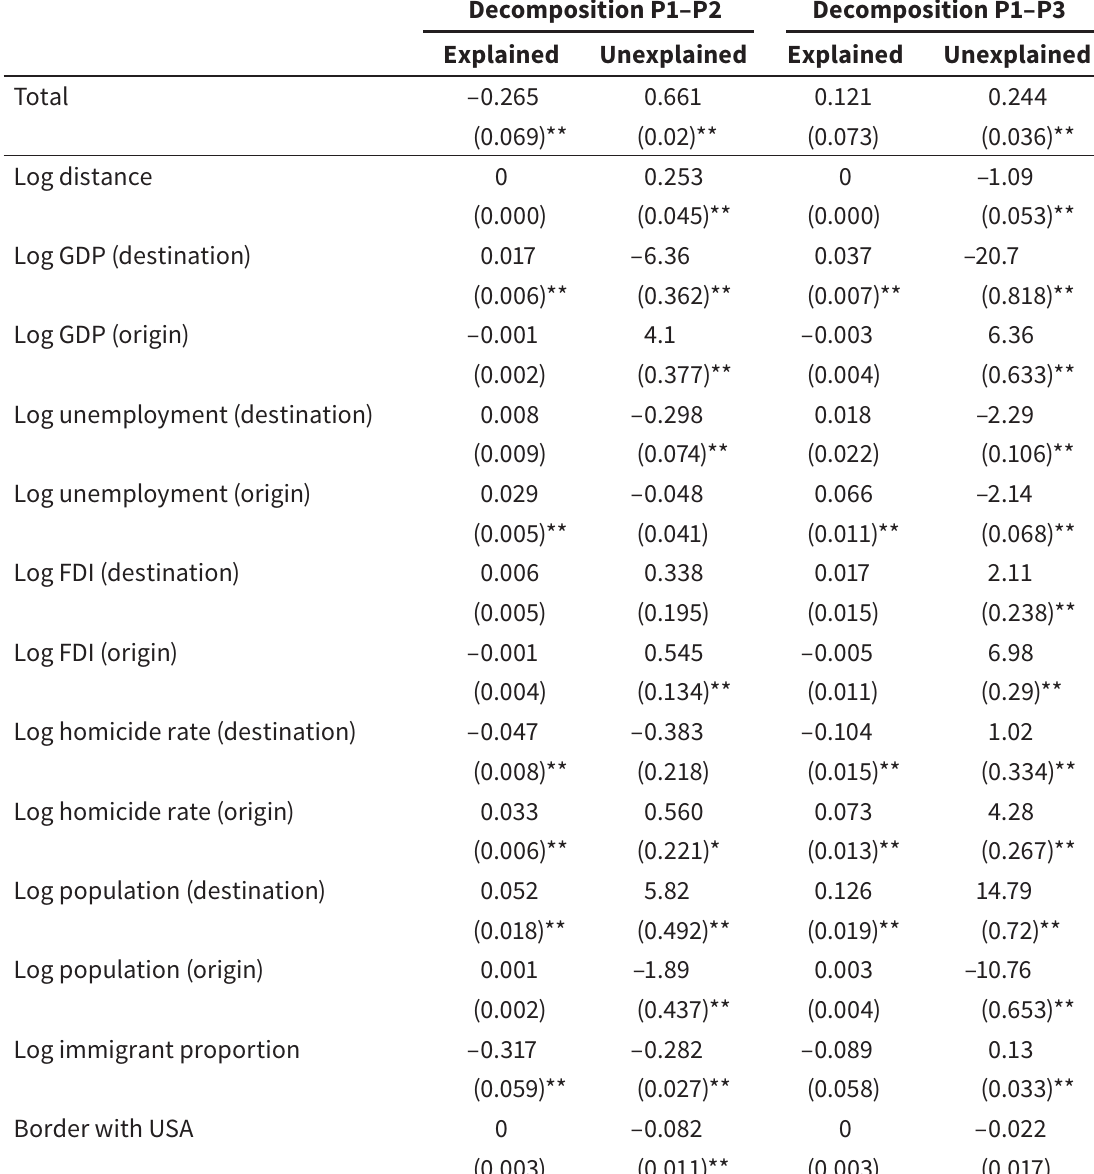
Decomposition of mean predictions differences between periods 1 and 2, and periods 1 and